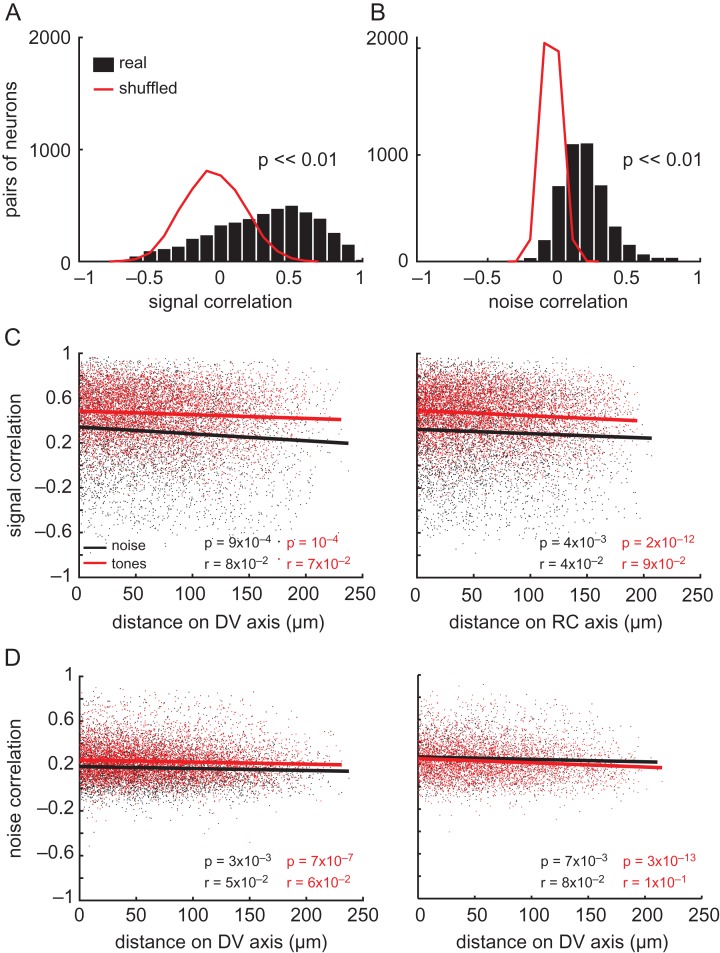
Comparisons of binaural and frequency preferences within the local cortical microcircuit. (A) Distributions of pairwise signal correlations during ILD stimuli presentation are shown for real (black bars) and shuffled (red line) data. The p value is indicated for a paired t-test between the 2 distributions. (B) Data presented as in (A), but for noise correlations. (C) Signal correlations calculated during presentation of ILD stimuli (black dots and line) and pure tones (red dots and line) as a function of dorso-ventral (left) and rostro-caudal (right) cortical distance between simultaneously imaged neuronal pairs. (D) Noise correlations presented as in C. In (C) and (D), lines indicate the best linear fit to the data.